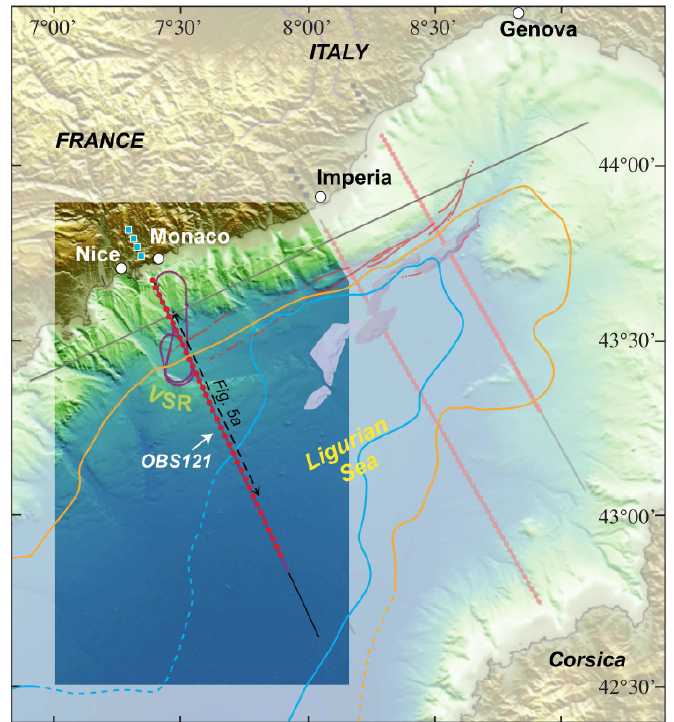
Figure 3. Ship tracks followed during the acquisition of the profiles of leg 1, together with those planned for leg 2, within the toned-down area (note the fourth transverse multichannel seismic (MCS) profile in grey to the north, connecting the three main lines across the basin, acquired both in MCS imaging and using Ocean Bottom Seismometers (OBSs), see text for details). Red dots stand for OBSs and blue squares for land stations. Purple and dark lines stand for MCS and OBS shot tracks followed during the cruise, respectively. The orange and bright blue lines separate the continental, transitional, and central domains in the basin, respectively [10]. Red lines, pale patches, and VSR label are as in Figure 2a. The black dashed line indicates the extent of the MCS profile displayed and discussed further.